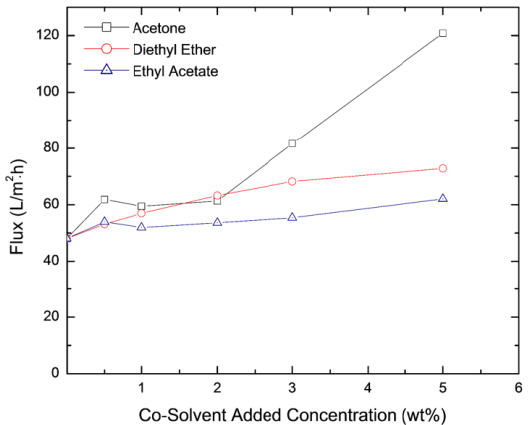
Figure 9. Flux of MgCl 2 through membranes formulated with acetone, diethyl ether and ethyl acetate added as co-solvents.